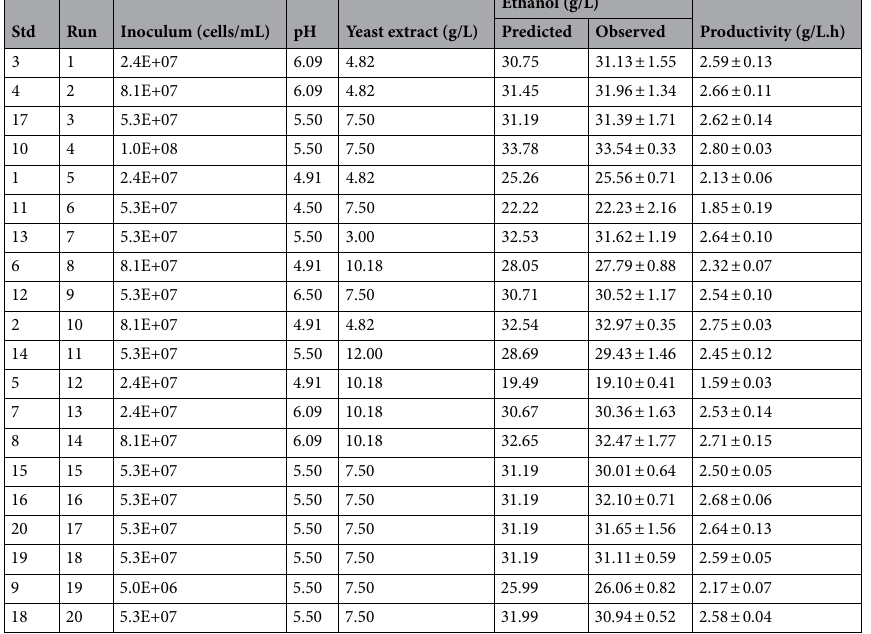
Table 7. The central composite design matrix for ethanol production using S. cerevisiae HG1.1 at 40 °C.